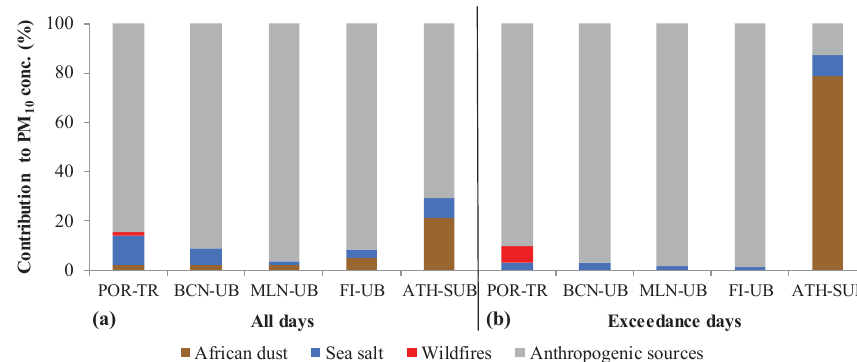
Figure 4. Mean source contributions (%) to PM 10 concentrations during all days (left) and days with exceedance of the 24h limit value (right). In the case of Barcelona, no exceedance was observed, so days with concentrations greater than the 90th percentile were selected as representative of high-pollution days.